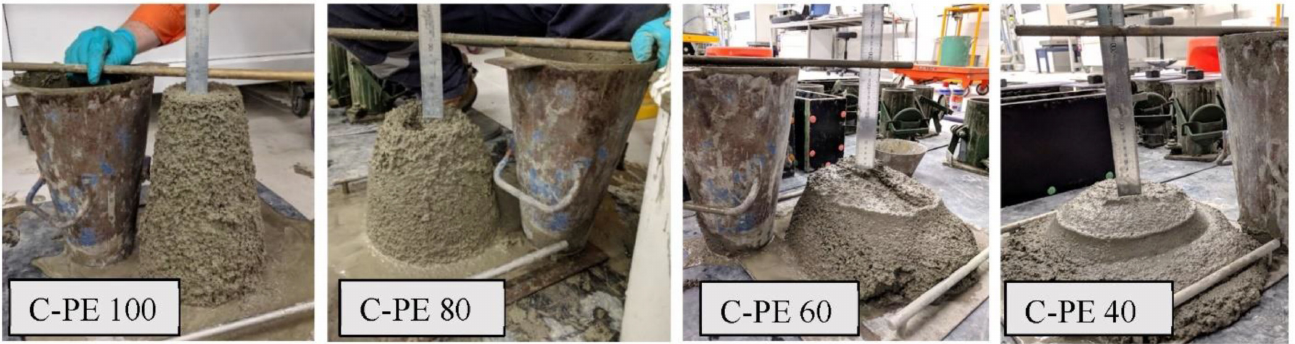
Figure 19. Slump tests of C-PE